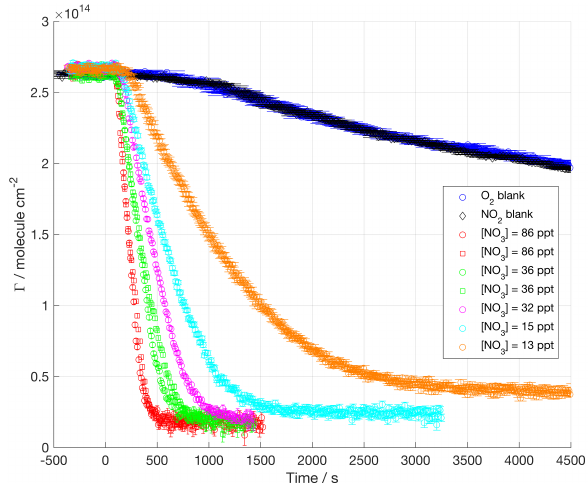
Figure 8. Surface excess of methyl oleate ( d 33 MO) exposed to dif- ferent [NO 3 ]; mean values are displayed in the legend. NO 3 expo- sure is started at t = 0s.